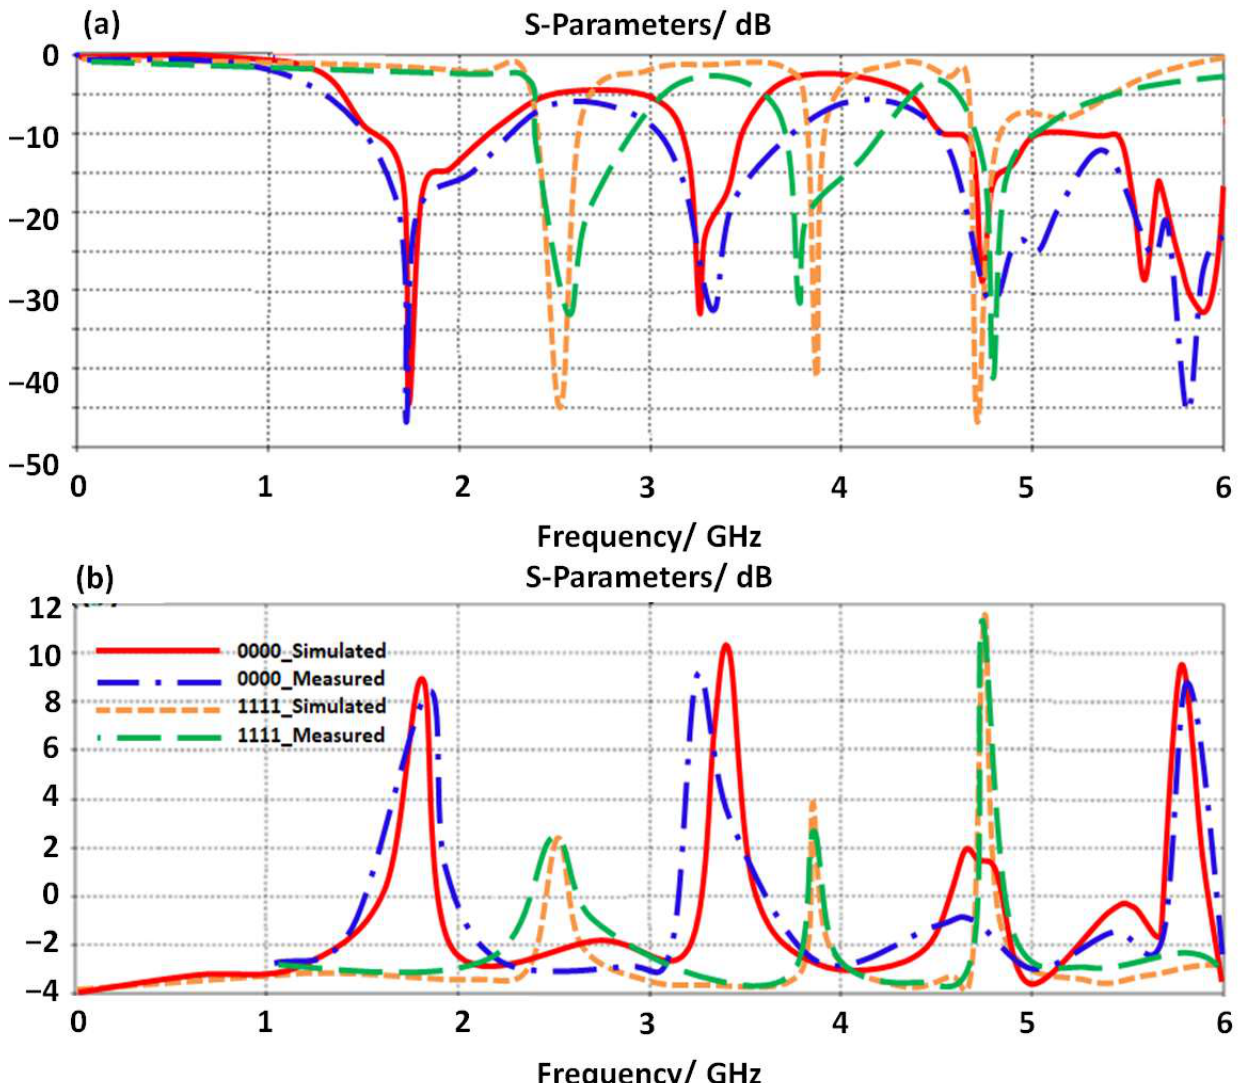
Figure 8. Antenna performance measurements with different switching sceneries: ( a ) S 11 spectra and ( b ) gain.